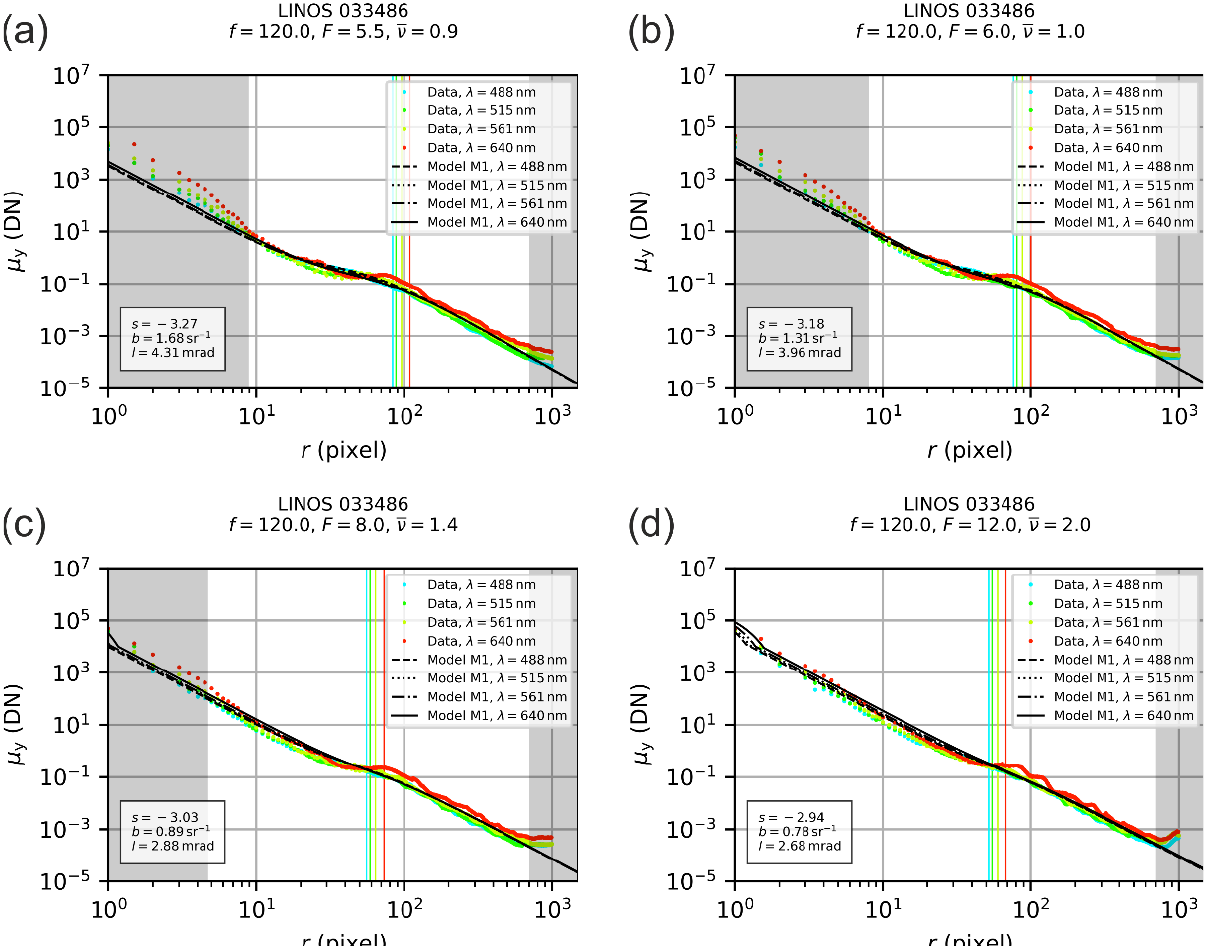
Figure 6. Fit of our theoretical model, according to Section 2.1, to the radial irradiance profiles at the focal plane derived from experimental data for the LINOS 033486 laser focusing lens: ( a ) f-number 𝐹 = 5.5 , ( b ) f-number 𝐹 = 6.0 , ( c ) f-number 𝐹 = 8.0 , ( d ) f-number 𝐹 = 12.0 .